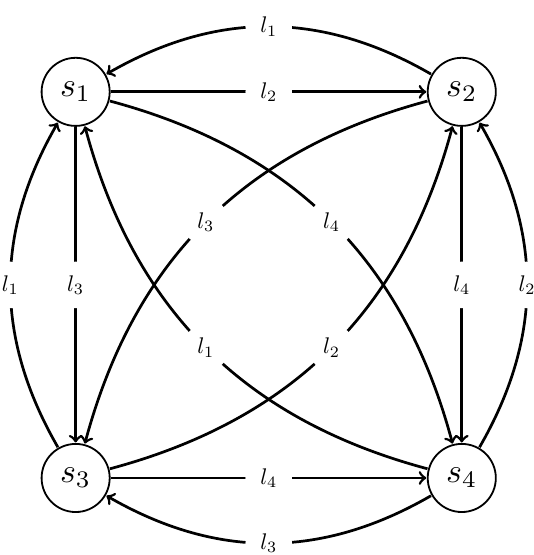
Figure 2. An example of the intermediate representation of an input text with four sentences. The length of Sentence 1 ( s 1 ), Sentence 2 ( s 2 ), Sentence 3 ( s 3 ), and Sentence 4 ( s 4 ) are l 1 , l 2 , l 3 , and l 4 ,